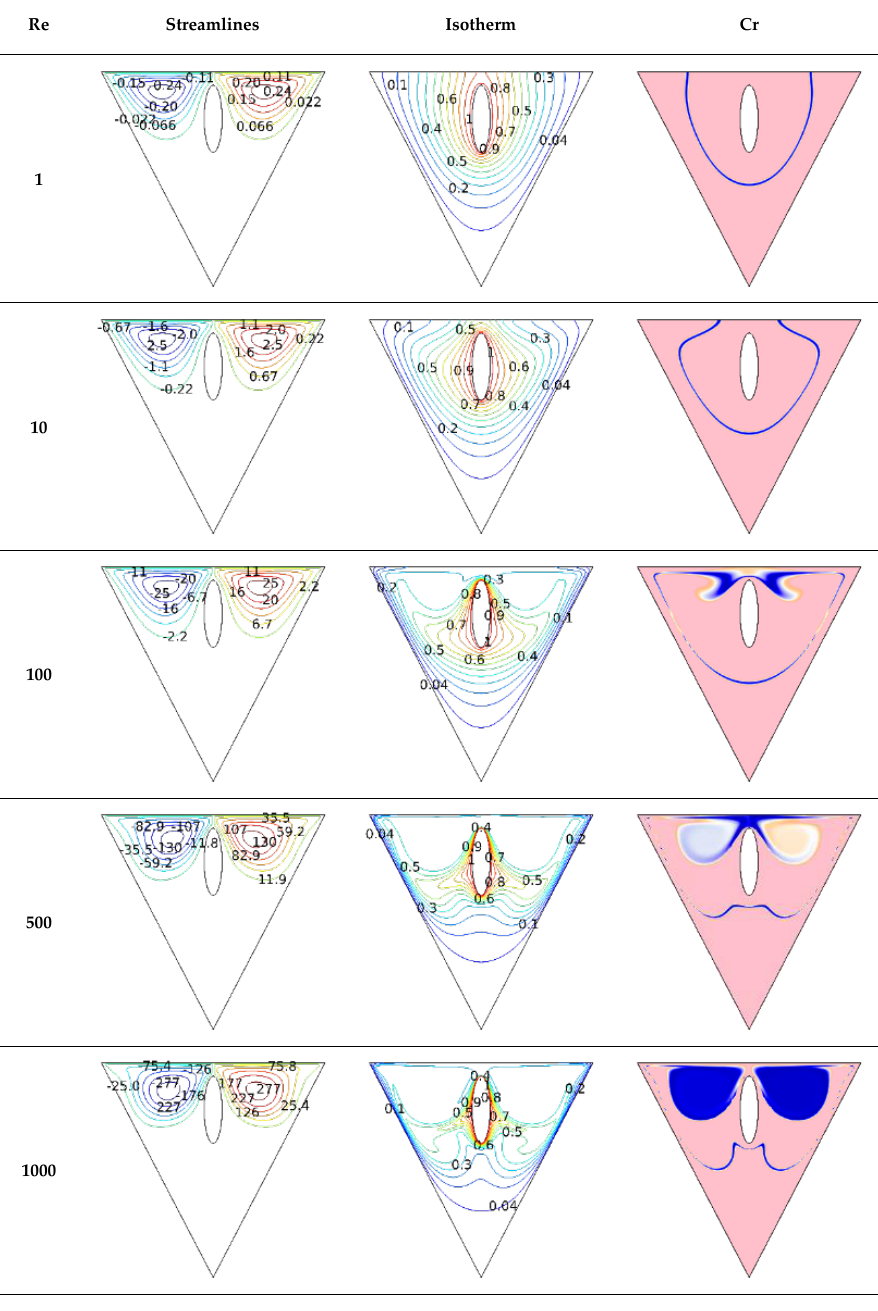
Figure 3. Features of the streamlines ( left ), isotherms ( middle ) and capacity ratio of NECPCM ( right ) for various values of Re. (The negative and positive sign numbers in the streamlines represent the direction and strength of flow, while the numbers in the isotherms mean the heating level.) In Figure 4, the inner-elliptic shape is inclined by various angles 𝛾 = 0,30,60,90 . The impacts of this rotation on the flow features, temperature and 𝐶𝑟 distributions are examined using this illustration. Various configurations for the streamlines are seen as 𝛾